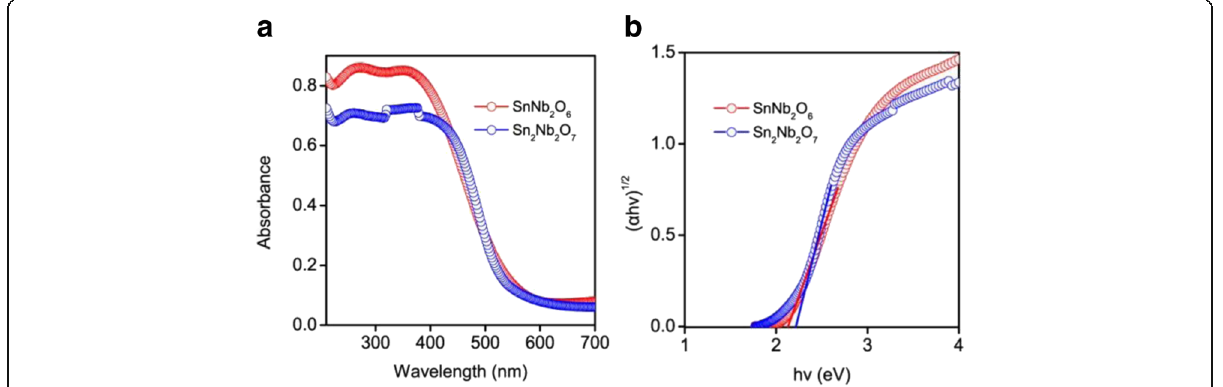
Fig. 3 UV-visible diffuse reflectance spectra ( a ) and optical band gap ( b ) of the as-prepared SnNb 2 O 6 and Sn 2 Nb 2 O 7